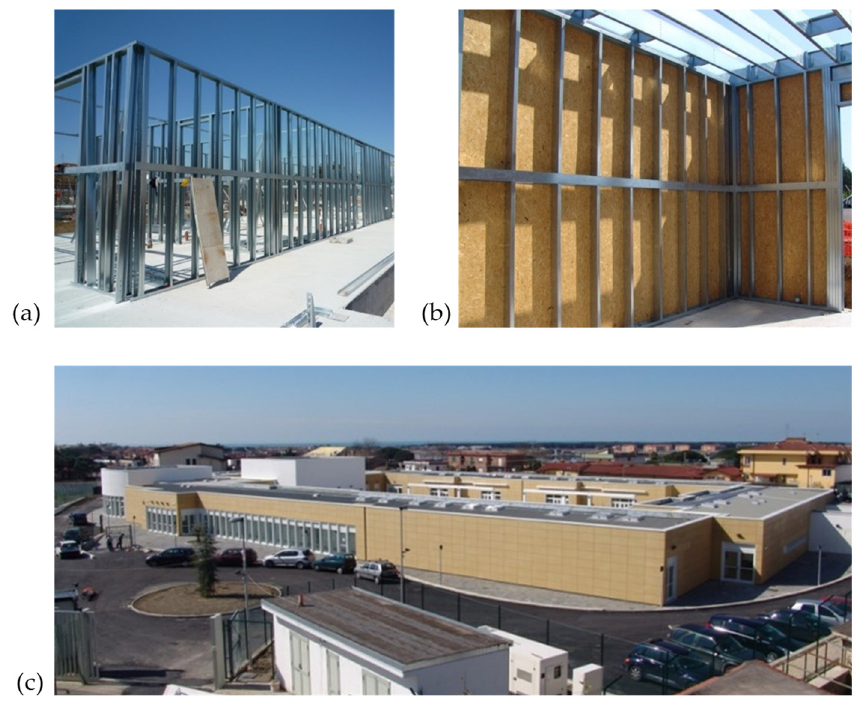
Figure 1. CFS school construction process: ( a ) CFS structural walls, ( b ) Sheathing of CFS walls, and construction of the roof, ( c ) Finishing and final result.